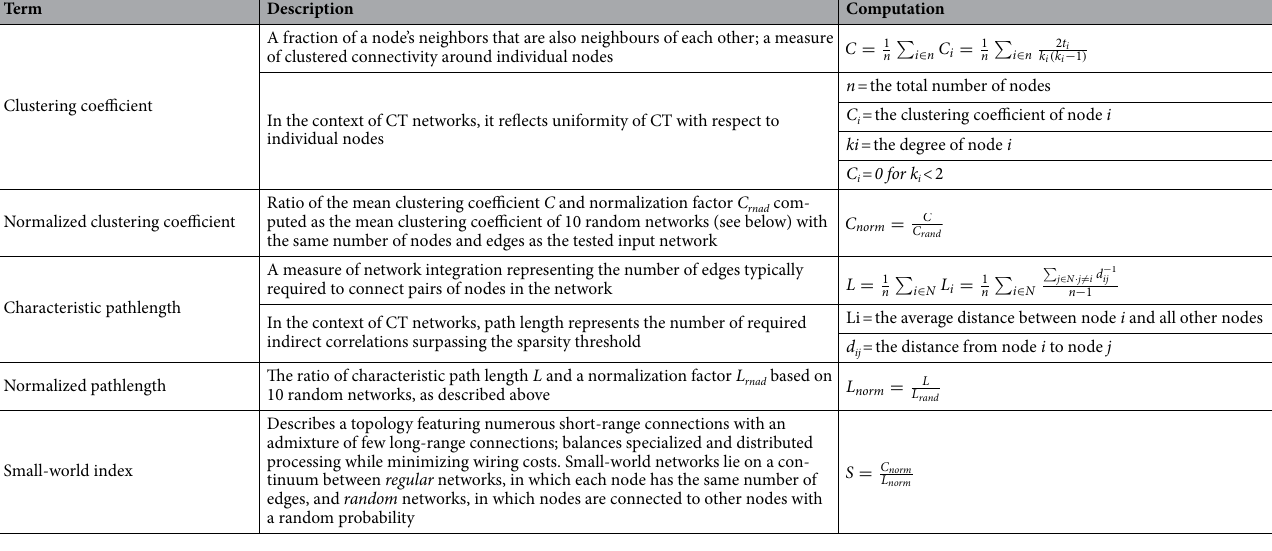
Table 2. Graph theory